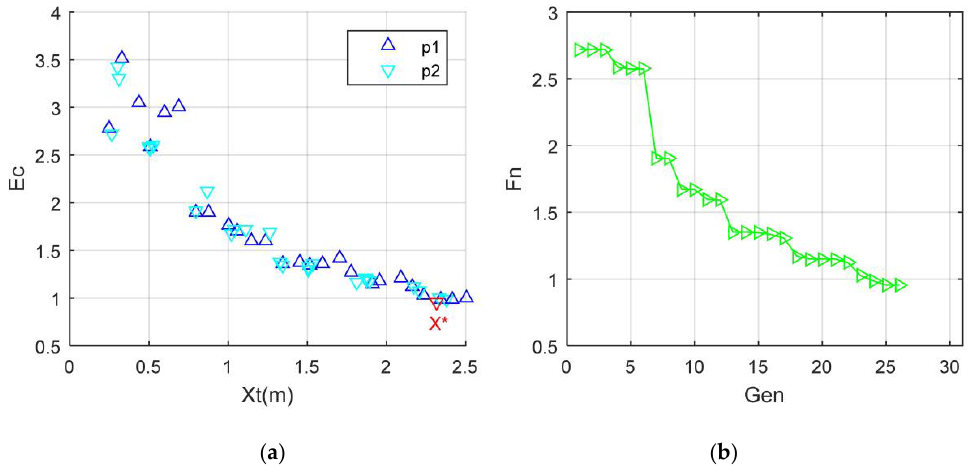
Figure 15. Stealth-aerodynamic optimization: C qw1 = 0.37 ; C qw2 = 0.63; α m = 50 ° ; F rh = 6 GHz; β = 0 ° ; X m = 2.5 m; V ∞ = 125.8 m/s; ( a ) E c results; ( b ) F n results. X m = 2.5 m; V ∞ = 125.8 m/s; ( a ) E c results; ( b ) F n results.